Question: Reading the figure, is the described quantity rising or falling?
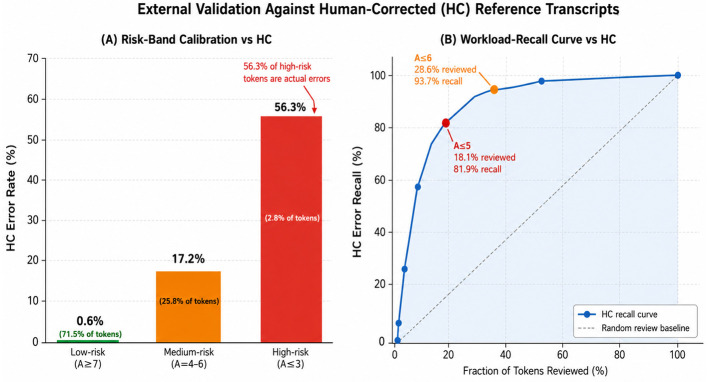
Answer: increasing